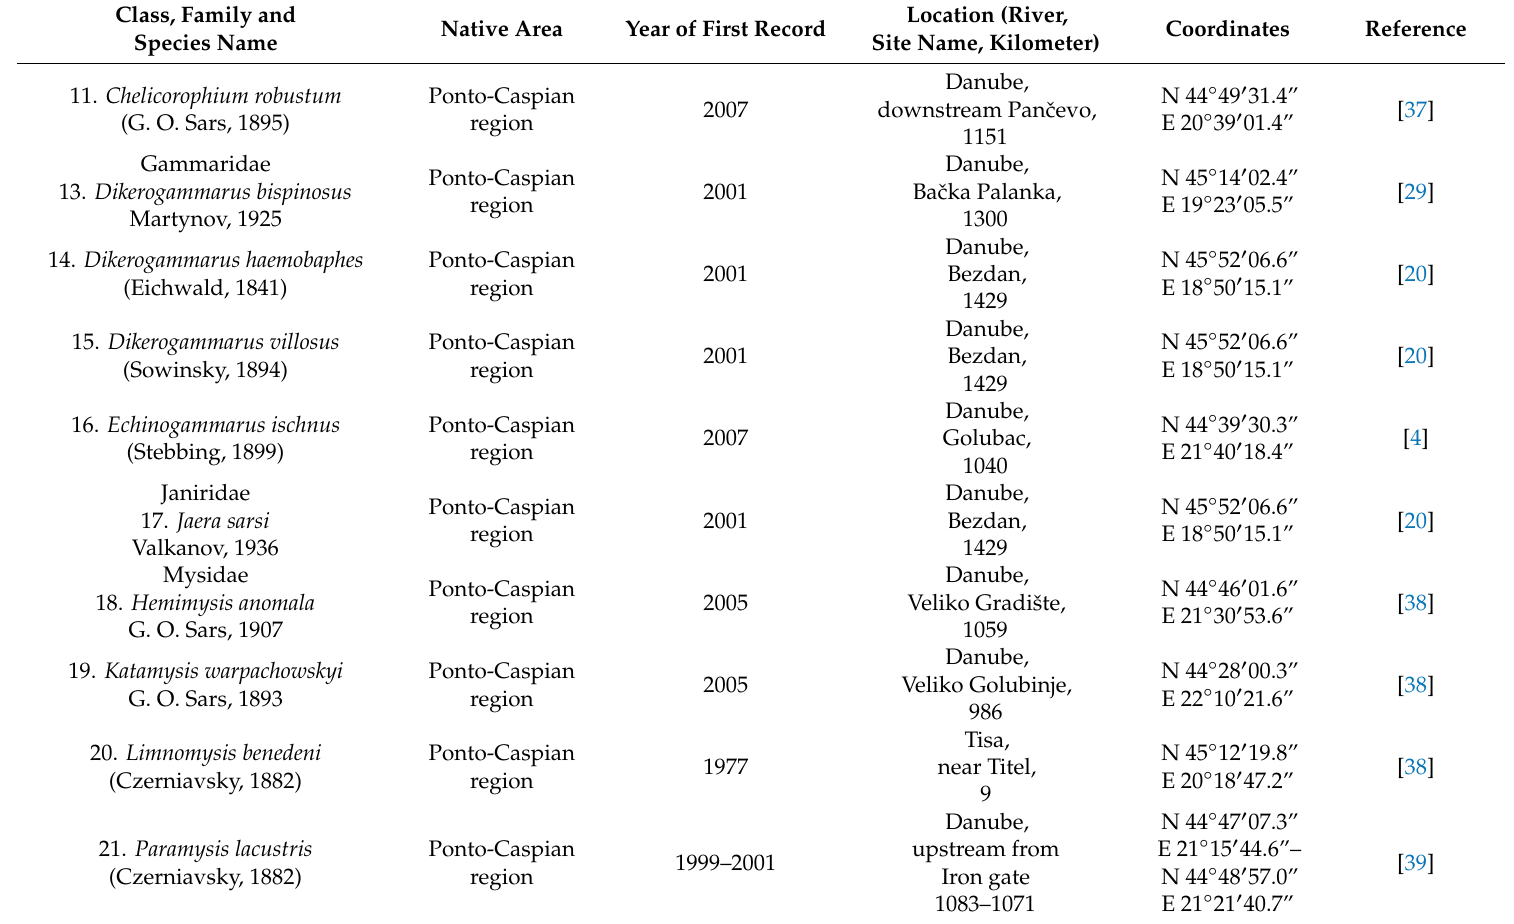
Table 2. Allochthonous macroinvertebrate species in watercourses of Serbia. (JDS 3—Joint Danube Survey 3). Class, Family